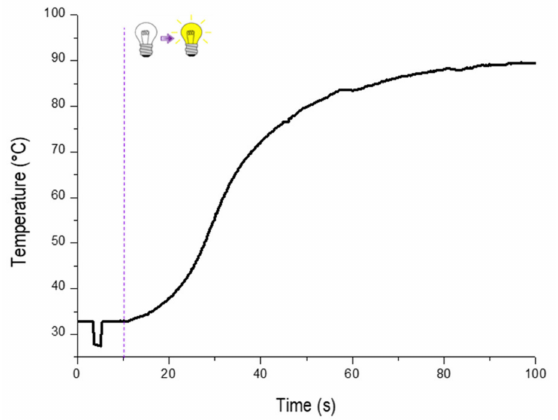
Figure 6. Thermal imaging photopolymerization follow-ups (temperature vs. irradiation time; 1.4 mm sample) under air upon LED@405 nm (110 mW cm − 2 ) irradiation for Mix-MA in the presence of